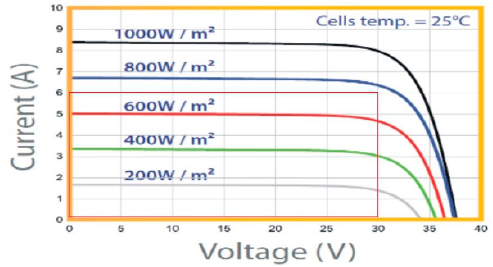
Figure 13. Operating range of model ERDM250 PV [35].